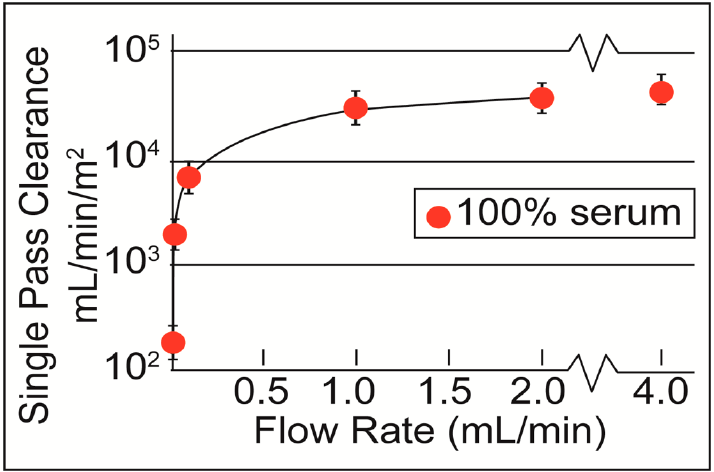
Figure 6. Single-pass clearance of urea in 100% serum, normalized to the membrane surface area. Adapted from Advanced Healthcare Materials, Wiley Publishing, 2020. [5].